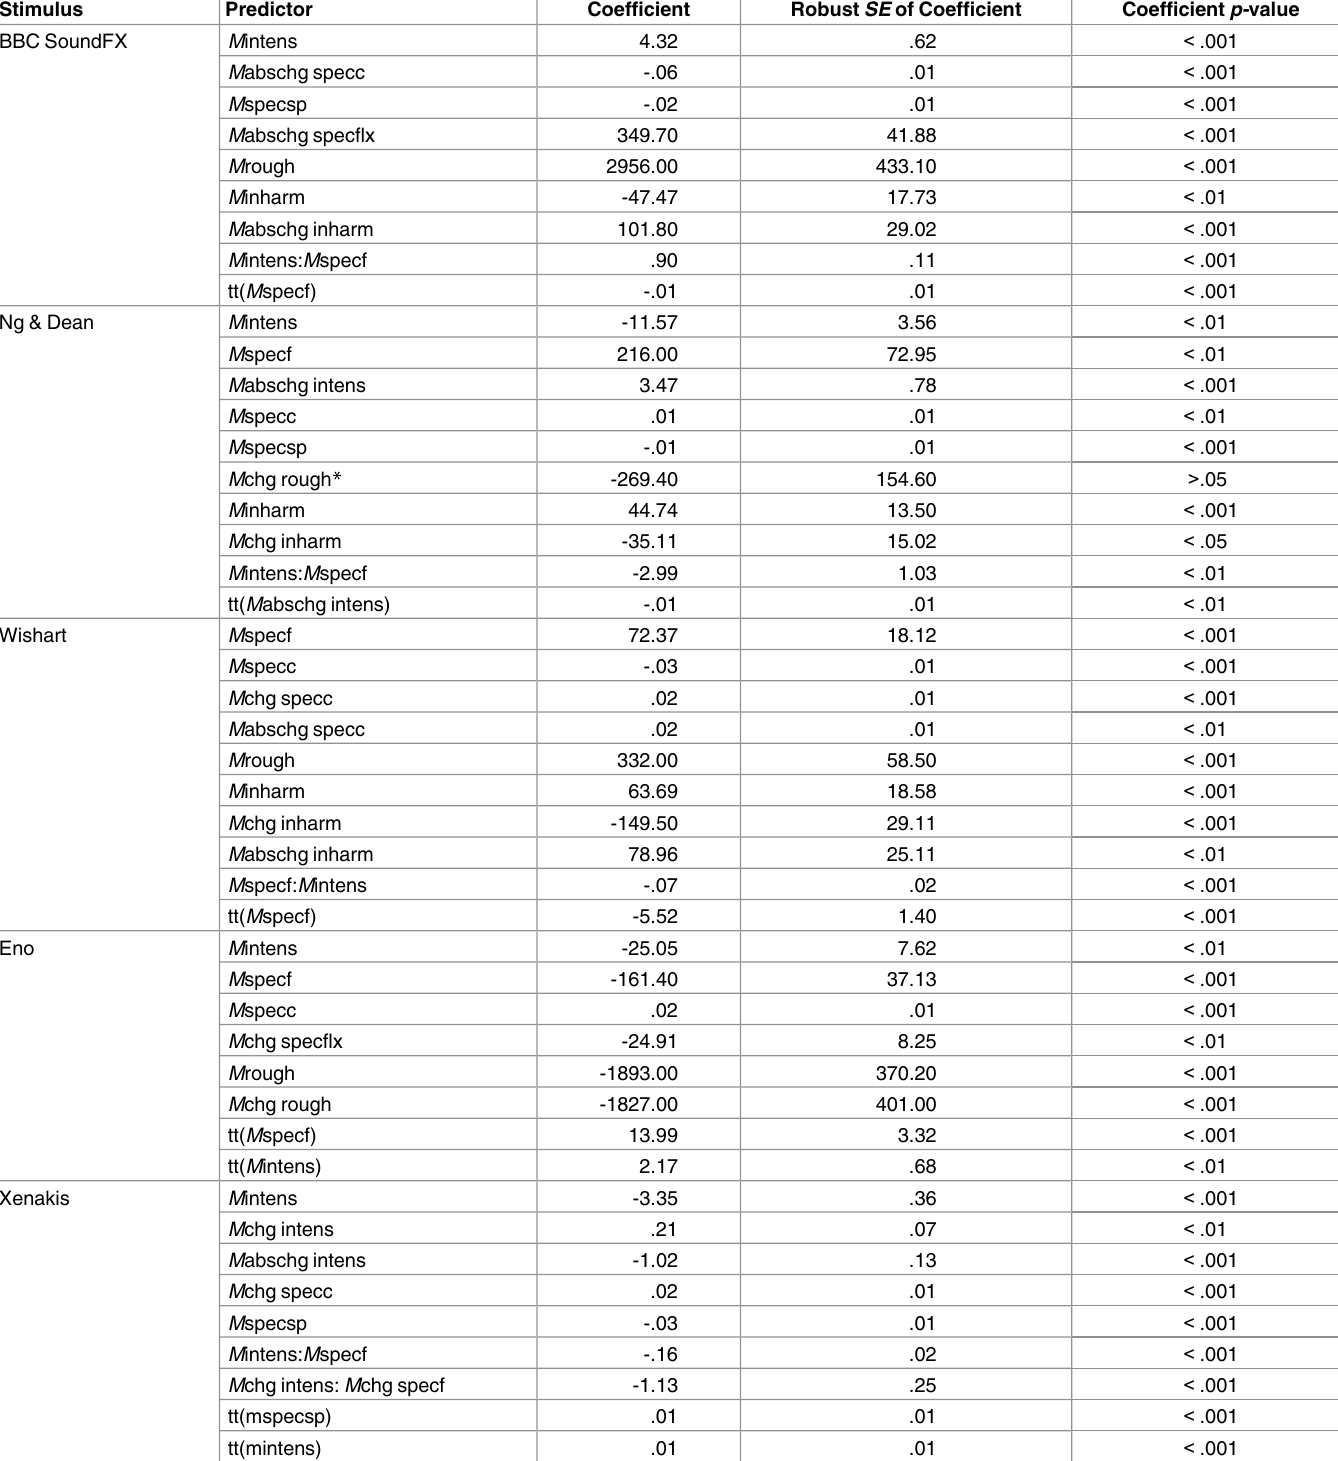
Table 7. Predictors in the selected cox hazard models of perceived phrases using the global approach and additional spectral parameters.